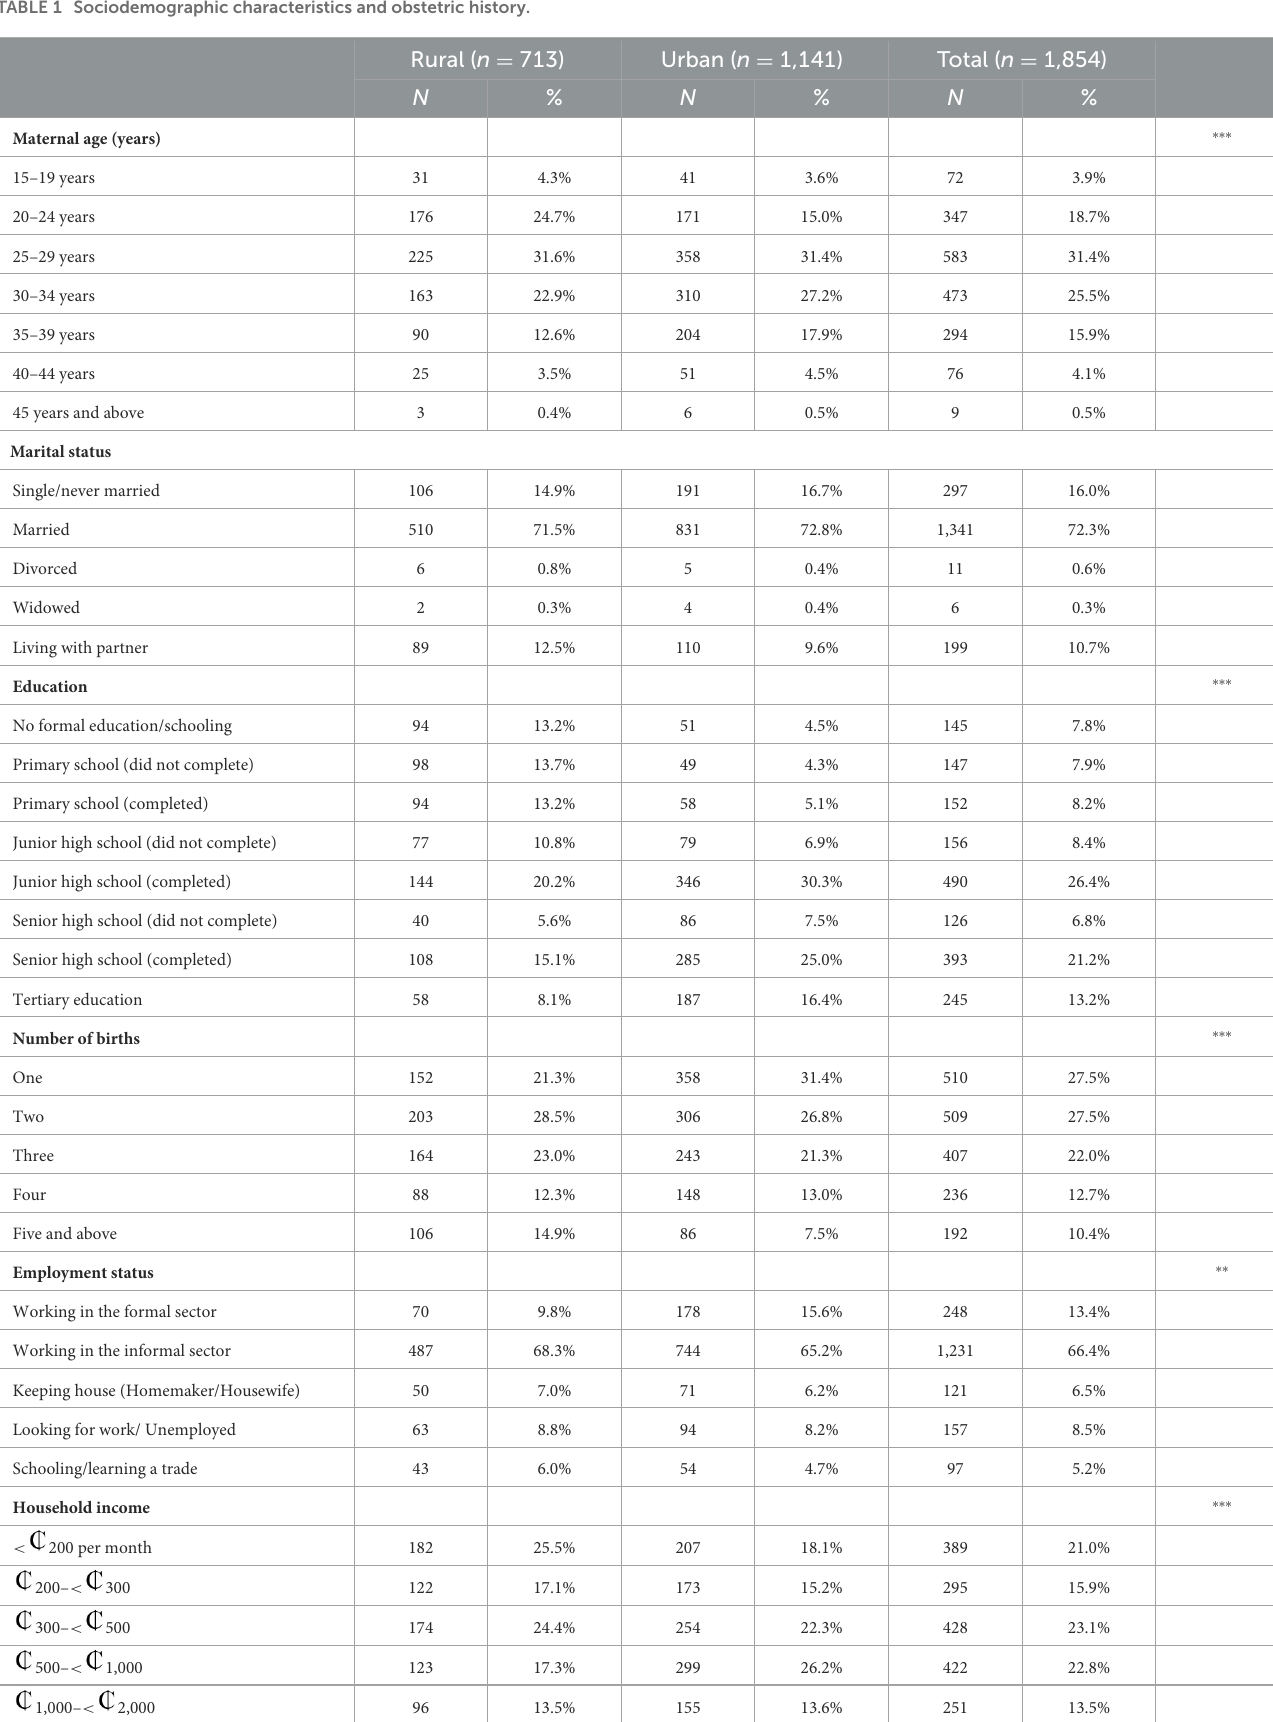
TABLE 1 Sociodemographic characteristics and obstetric